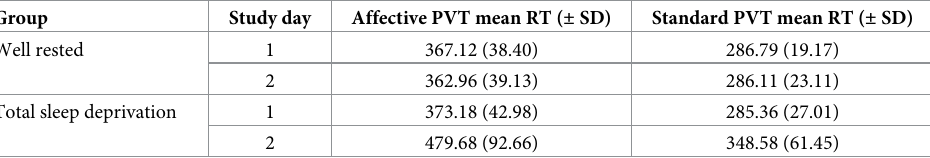
Table 2. Means and standard deviations of RTs (ms) for the affective and standard PVT across study days.